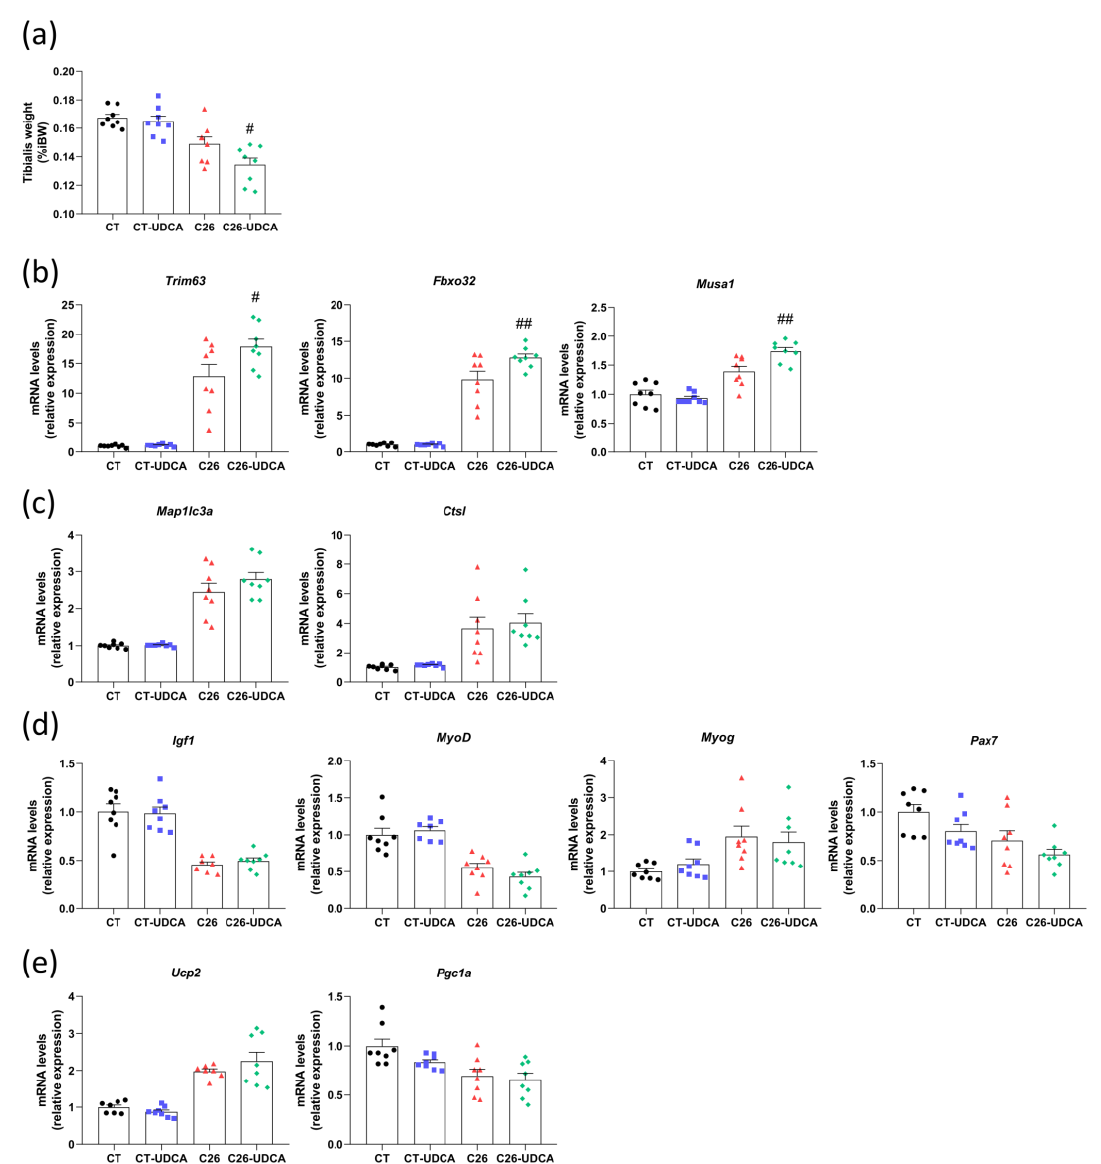
Figure 6. UDCA treatment worsens muscle atrophy in C26 cachectic mice. ( a ) Tibialis weight in sham-injected mice (CT), sham-injected mice treated with UDCA (CT-UDCA), mice injected with cachexia-inducing C26 colon carcinoma cells (C26), and mice injected with cachexia-inducing C26 colon carcinoma cells and treated with UDCA (C26-UDCA). Tibialis mRNA expression levels of genes involved in the ubiquitin-proteasome pathway ( b ), autophagy-lysosome pathway ( c ), differentiation ( d ), and mitochondrial function ( e ). Trim63 , tripartite motif-containing 63 (also known as Murf1); Fbxo32 , F-box protein 32 (also known as Atrogin1); Musa1 , muscle ubiquitin ligase of the SCF complex in atrophy 1; Map1lc3a , microtubule-associated protein 1 light chain 3 alpha; Ctsl , cathepsin L; Igf1 , insulin-like growth factor 1; Myog , myogenin; MyoD , myogenic differentiation 1; Pax7 , paired box 7; Ucp2 , uncoupling protein 2; Ppargc1a , PPARG coactivator 1 alpha. n = 7–8 mice per group; data are presented as mean ± SEM. # p < 0.05 ## p < 0.01 C26 vs.